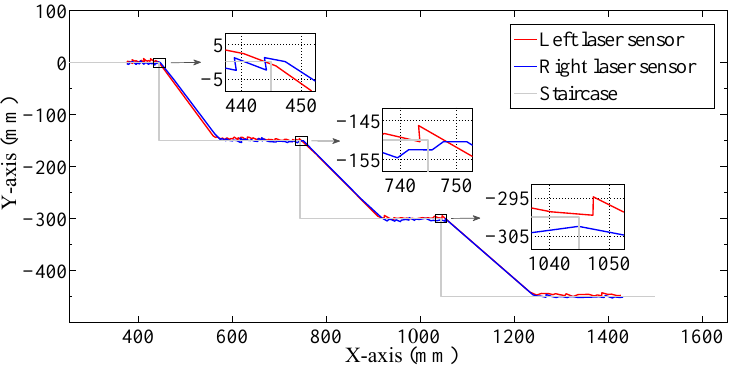
Figure 10. Estimated shape and size of the